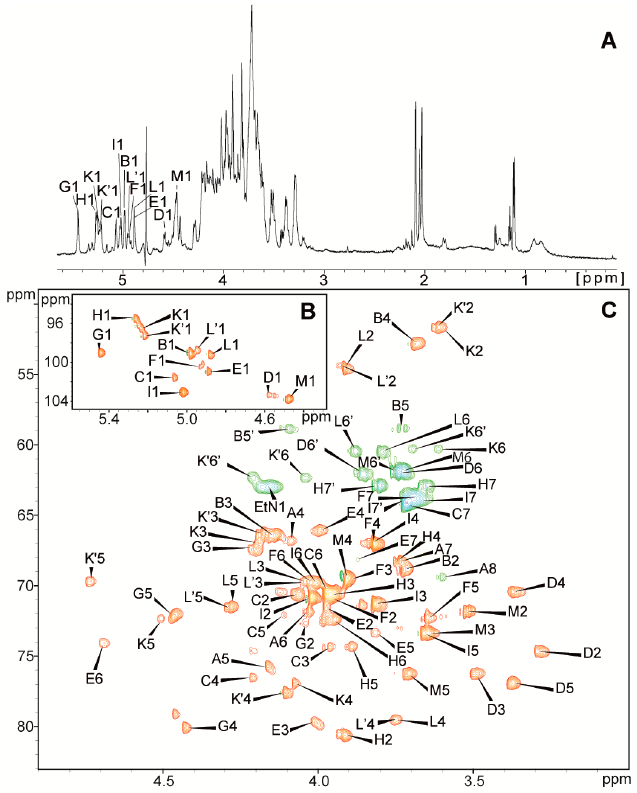
Figure 3. ( A ) The 1 H NMR spectrum and ( B , C ) selected regions of the 1 H- 13 C HSQC-DEPT spectrum of the core oligosaccharide P. penneri 40A LPS. The cross-peaks are labeled as shown in the text. Residue M at δ H / δ C 4.48/103.7 ppm, 1 J C-1,H-1 ~ 162 Hz, was recognized as the terminal β - D -Gal p